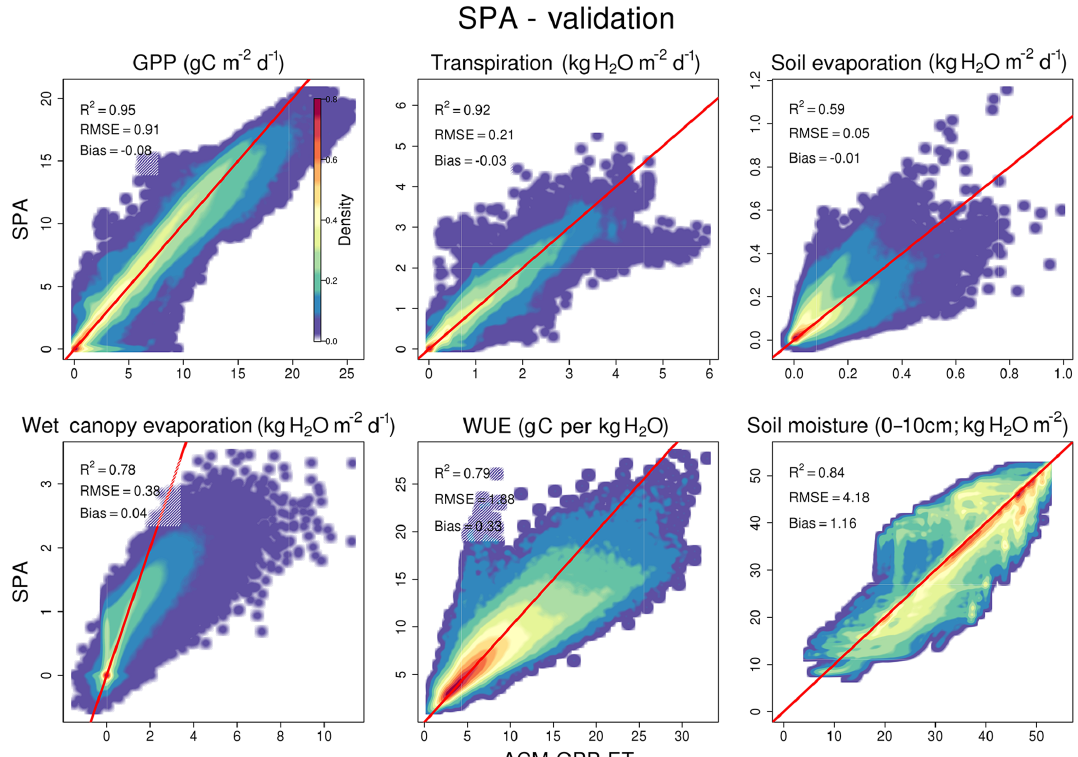
Figure 4. Comparison between ACM-GPP-ET- and SPA-simulated fluxes for model-based validation of ACM-GPP-ET’s ability to simulate coupled plant carbon and water cycle dynamics. ACM-GPP-ET uses the maximum likelihood parameter set from the calibration proce- dure. Fluxes compared are gross primary productivity (gCm − 2 d − 1 ), transpiration (kgH 2 Om − 2 d − 1 ), soil evaporation (kgH 2 Om − 2 d − 1 ) and evaporation of water intercepted by the canopy (kgH 2 Om − 2 d − 1 ). Also shown is the soil moisture content in the 0–10cm soil layer (kgH 2 Om − 2 ) and water use efficiency (WUE = GPP /T ; gC/kgH 2 O). The red line is a 1 : 1 line for reference. The colour intensity from blue to red indicates the density of flux estimates within a given area. Note that for clarity, to show low-density areas, the density values are scaled by density 1 / 4